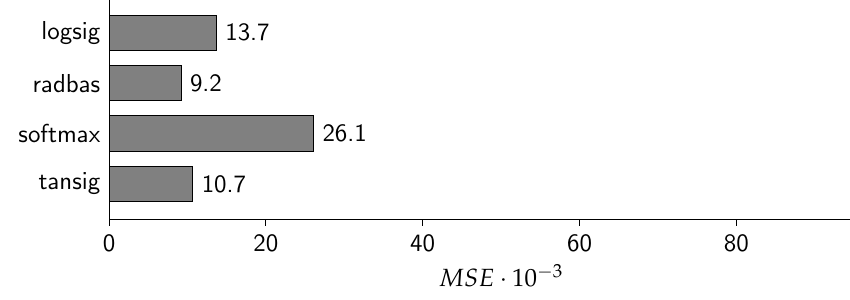
Figure 12. Mean square error. Table 6. Neural network